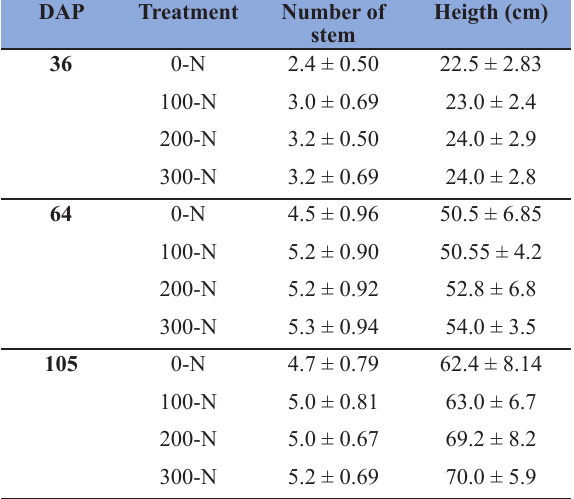
Table 2. Number of stem and plant height during days after planting (DAP) in the different treatments of nitrogen fertilization: 0, 100, 200 and 300 kg N ha -1